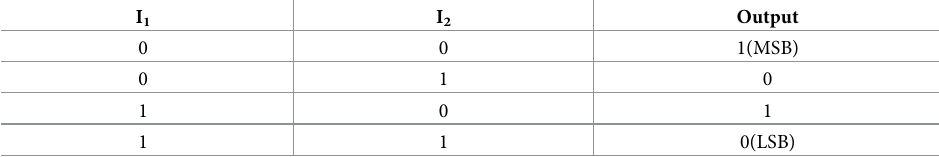
Table 2. An example function implemented by the two-input, one-output NLDBM logic